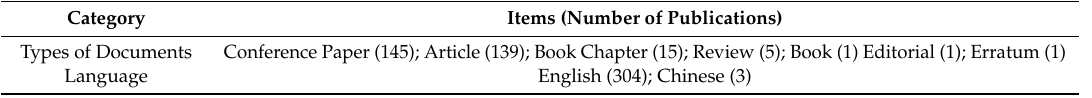
Table 1. Research sample